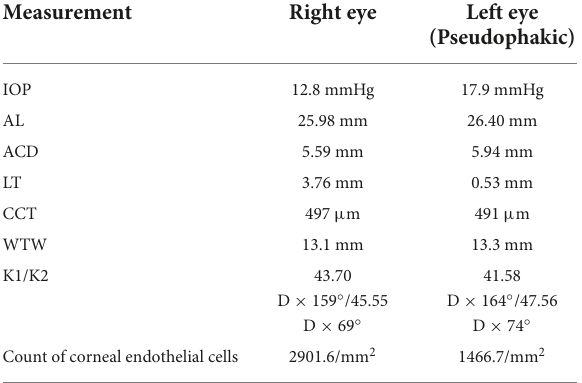
TABLE 1 Preoperative measurements of the